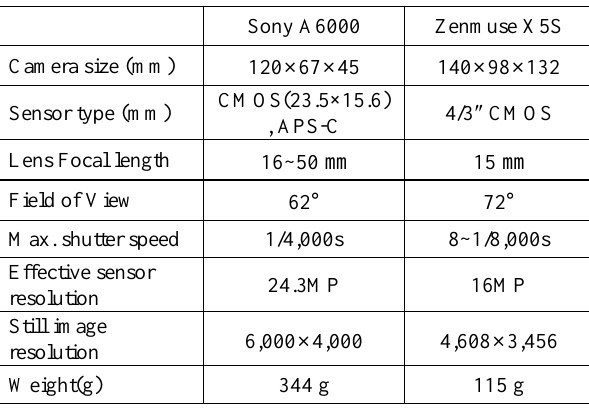
Table 2. Specifications of camera mounted